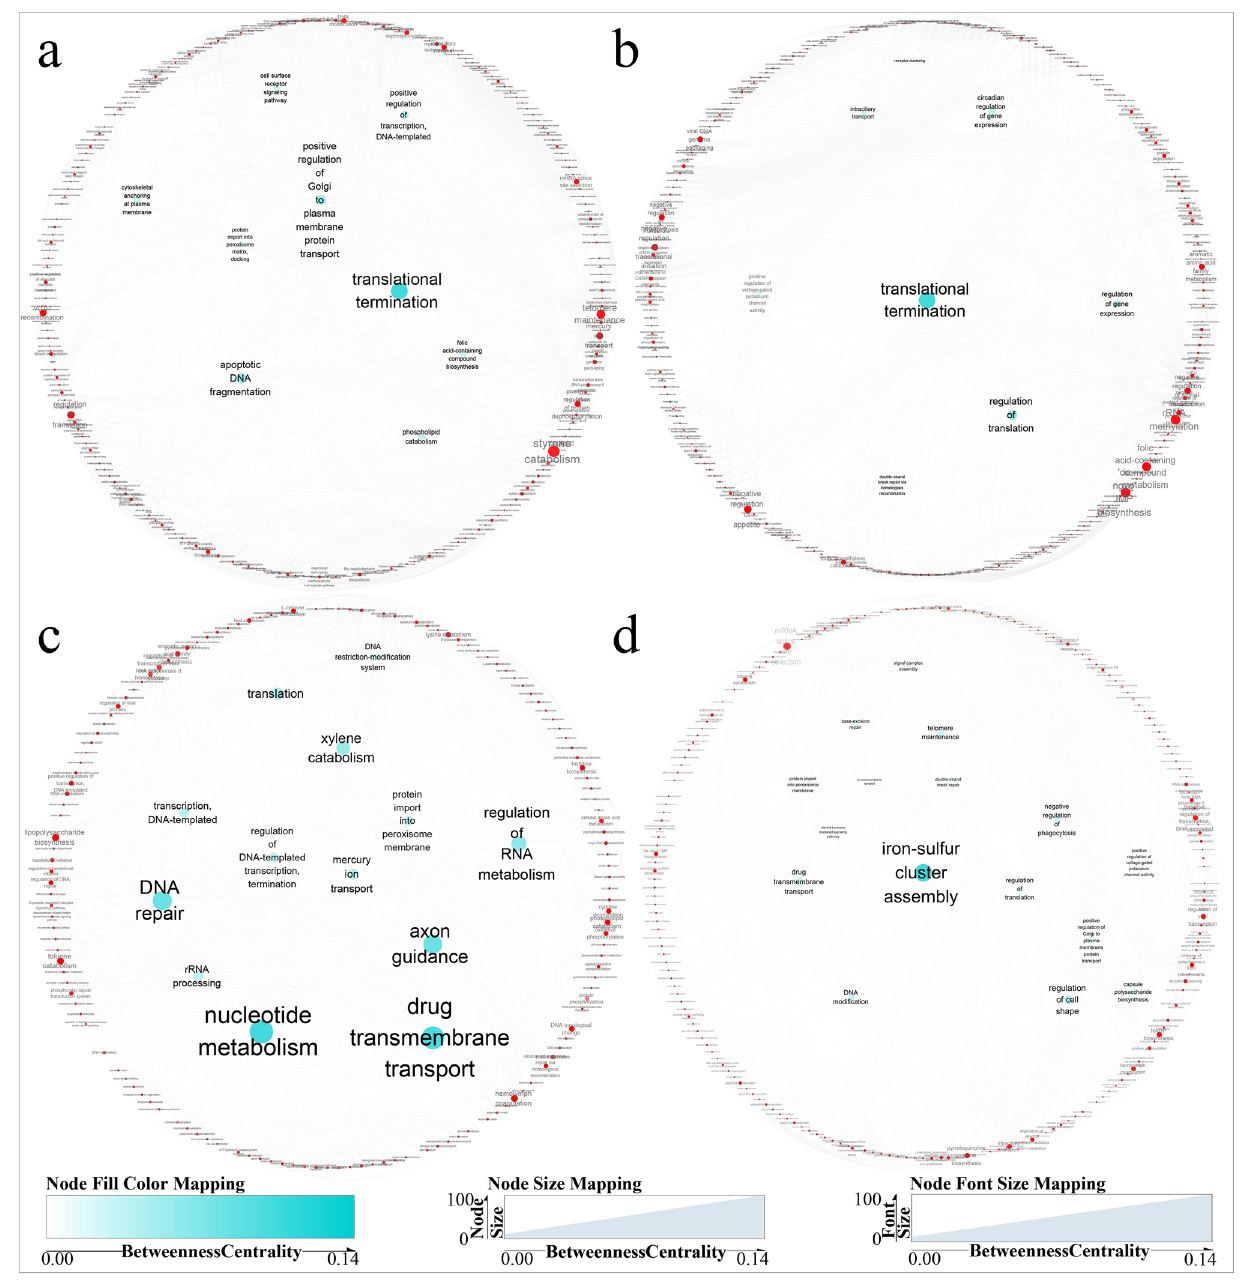
Figure 4. GO function annotation of short-acting genes in leaf ( a ); in rhizome ( b ). Go function annotation of long-acting genes in leaf ( c ); in rhizome ( d